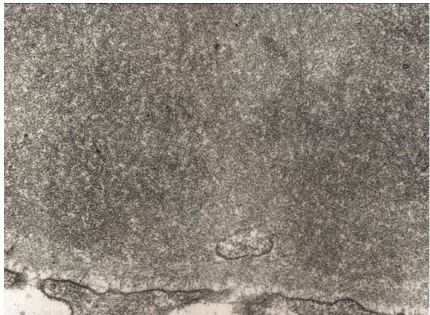
Figure 3: Membranoproliferative glomerulonephritis: PAS-positive “hyaline thrombi” seen within the capillary lumina (PAS, original magnification × 400).